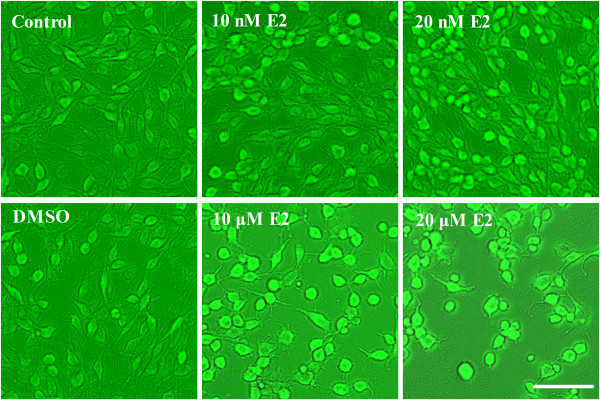
The effects of different doses of E2 on cultured PC12 cell morphology. PC12 cells treated with 10 nM or 20 nM E2 exhibited a marked increase in cell number. PC12 cells treated with 10 μM or 20 μM E2 (especially in the 20 μM group) exhibited a marked decrease in cell number with most cells losing their neurites and appearing round. Scale bar = 100 μM.